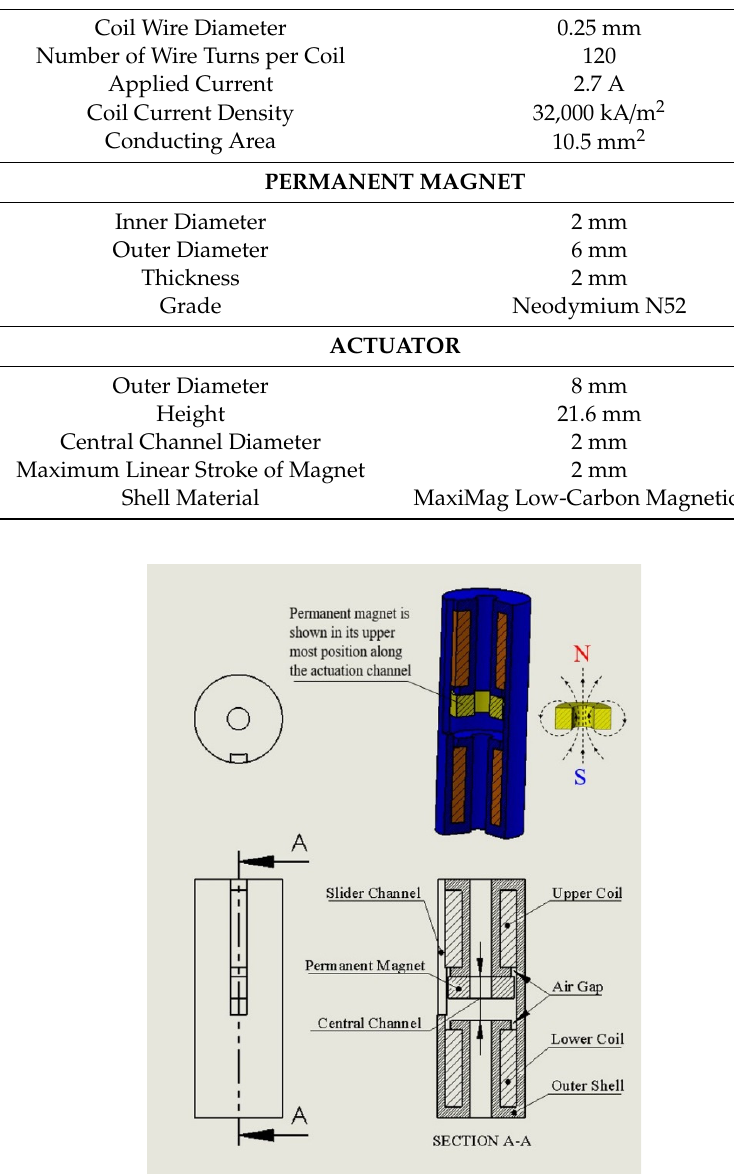
Figure 1. Top, isometric, front, and side views of the prototype actuator (clockwise from top